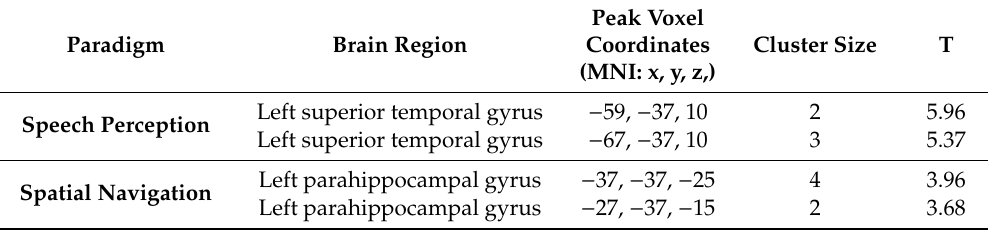
Peak Voxel Coordinates Cluster Size T (MNI: x, y, z,)